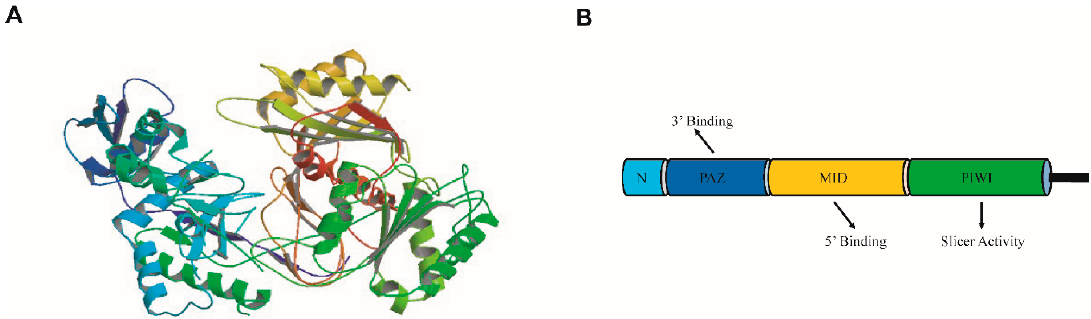
Figure 1. Domain schematics of a typical Argonaute protein. ( A ) Crystal structure of Aquifex aeolicus Argonaute (adapted from PDB database, PDB ID: 2NUB) [28], with stereo-view ribbon illustration of Argonaute showing the N-terminal domain (light blue), the PAZ domain (blue), the MID domain (yellow), the Piwi domain (green); ( B ) Schematic depiction of the Argonaute domain. PAZ domain anchors the characteristic 2-nt 3’ overhangs of small RNAs. The MID domain binds 5’ phosphates of small RNAs, and functions as an anchor of small RNAs binding to the Argonaute (AGO) protein. Piwi domain is an RNase H domain. Table 1. Characterized Argonaute (AGO) proteins in different species.